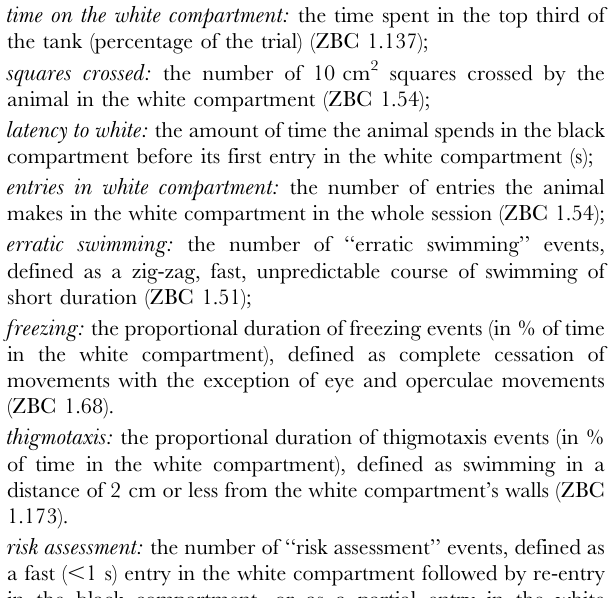
thigmotaxis: the proportional duration of thigmotaxis events (in % of time in the white compartment), defined as swimming in a distance of 2 cm or less from the white compartment’s walls (ZBC